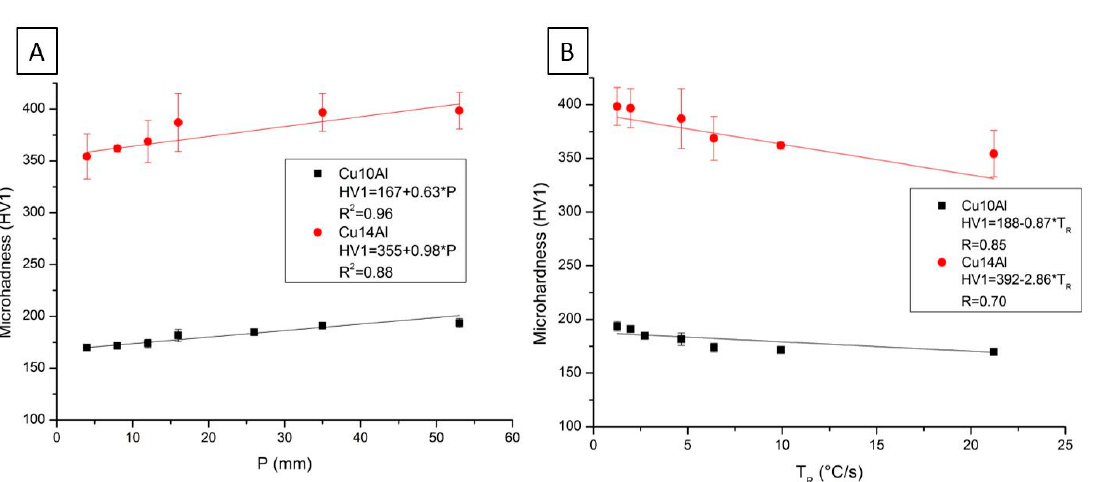
6 of 10 Figure 5. ( a ) Correlation between hardness (HB) and distance from heat extraction surface (P); and